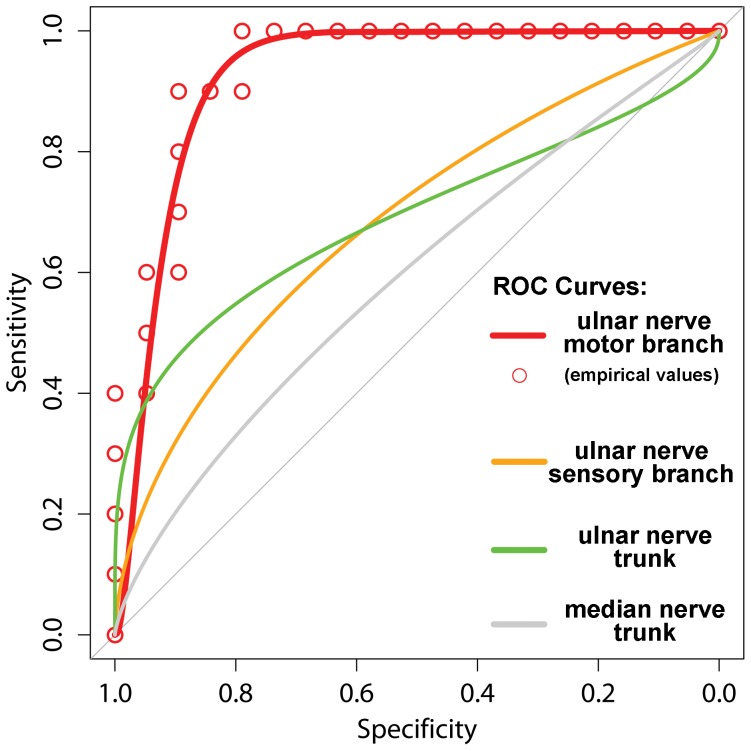
ROC plots of sensitivity versus specificity for the discrimination between GCS and healthy status.Nerve T2-signal was evaluated for its performance of diagnostic classification, empirical and fitted values are plotted. High diagnostic performance (AUC = 0.94) for nerve T2-signal of the deep motor branch was observed, while diagnostic of the ulnar nerve trunk (AUC = 0.70) and the superficial branch were significantly inferior (AUC 0.69).